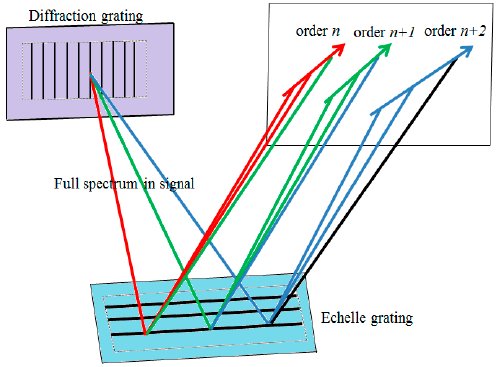
Figure 2. Schematic of cross-dispersion of the diffraction grating and the echelle grating.